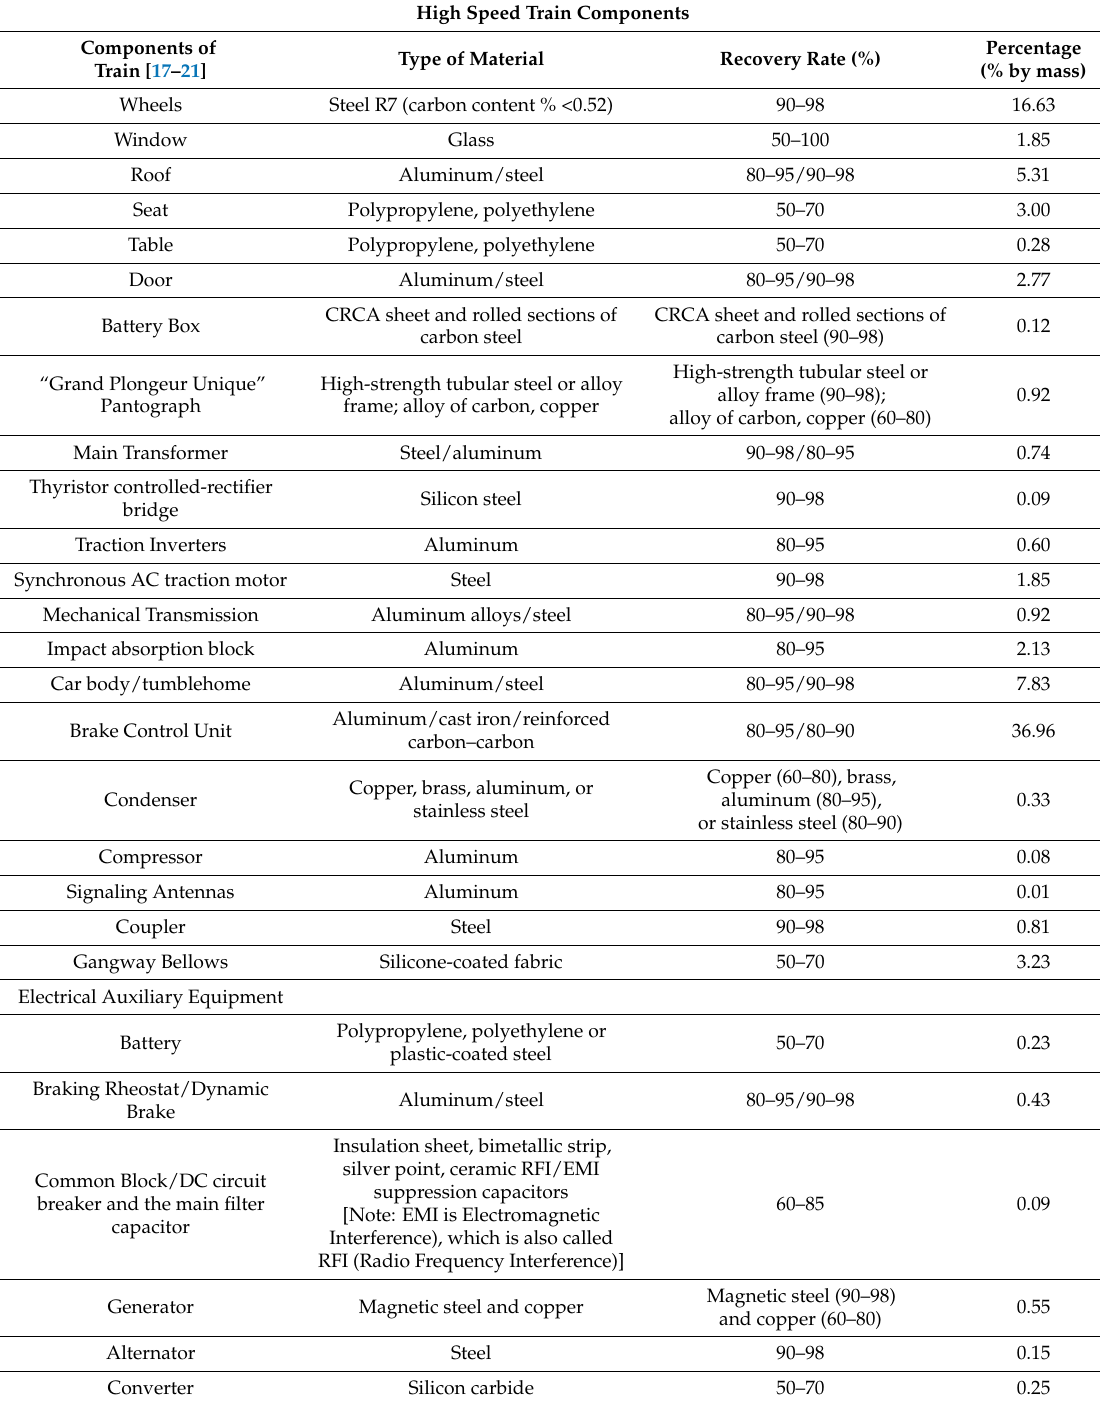
Table 3. Component analysis of high-speed trains (calculated from industry sources). Some component weights are available from the industry sources. All data has been taken from the parts manufacturers’ documents available on Union des Industries Ferroviaires Europ é ennes (UNIFE) and train companies’ websites. The furniture weights have been estimated from the